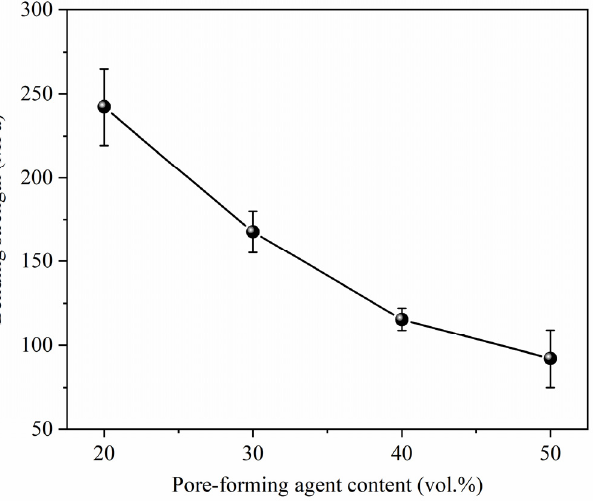
Figure 8. Relationship between the bending strength of porous alumina and the content of the